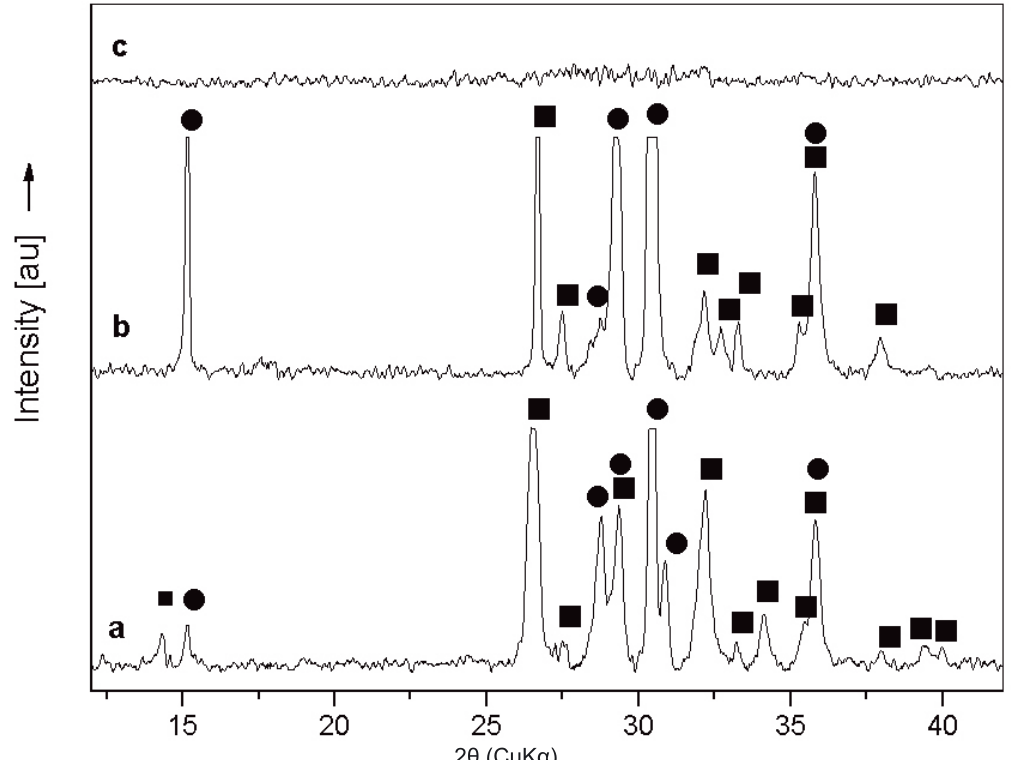
Figure 5. Powder diffraction patterns. a) sample containing in the initial mixture 95.00 mol% PbO, before melting; (b) after melting at 715°C and (c) after melting at 950°C. ■ - Pb BiVO (PDF: 50-0493), ● - PbO (PDF: 4 8